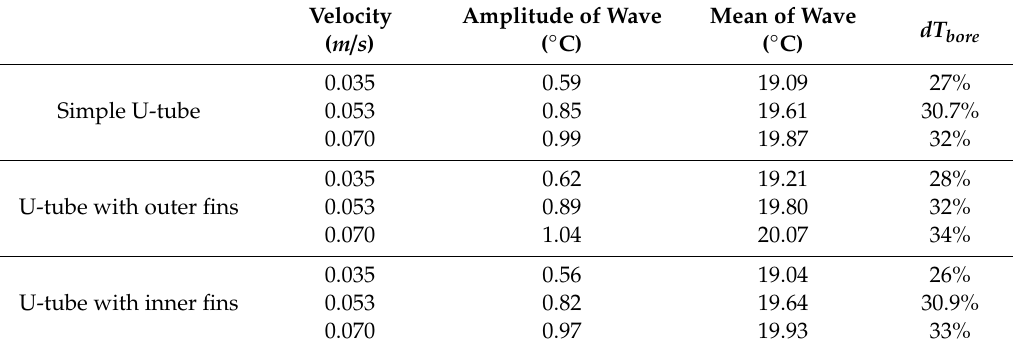
Figure 9. Borehole wall temperature trends under different velocities: ( a ) simple U-tube; ( b ) U-tube with outer fins; ( c ) U-tube with inner fins. Table 9. Borehole wall temperature with a frequency of 1/4800 Hz at different velocities.